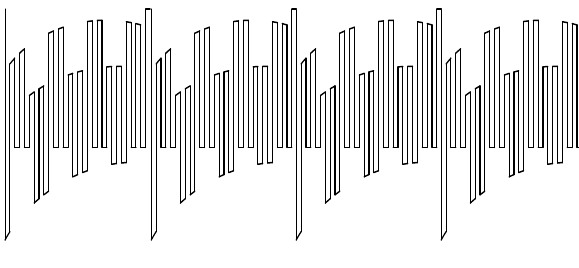
Figure 11. Waveform of DC-bus.